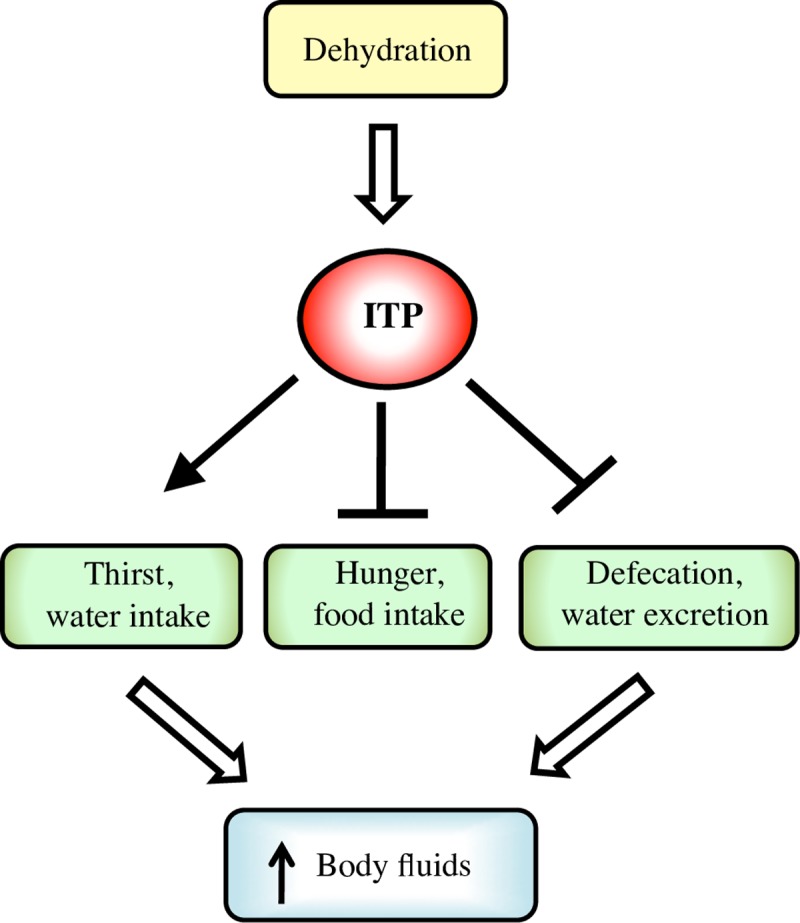
Scheme summarizing the roles of ITP in Drosophila, as revealed by this study.ITP is a central regulator of water balance. Conditions leading to reduced volume of body fluids result in increased expression of ITP gene. ITP subsequently promotes water intake, while inhibiting feeding and water loss by excretion, promoting thus the increase in body fluids and restoration of water balance.